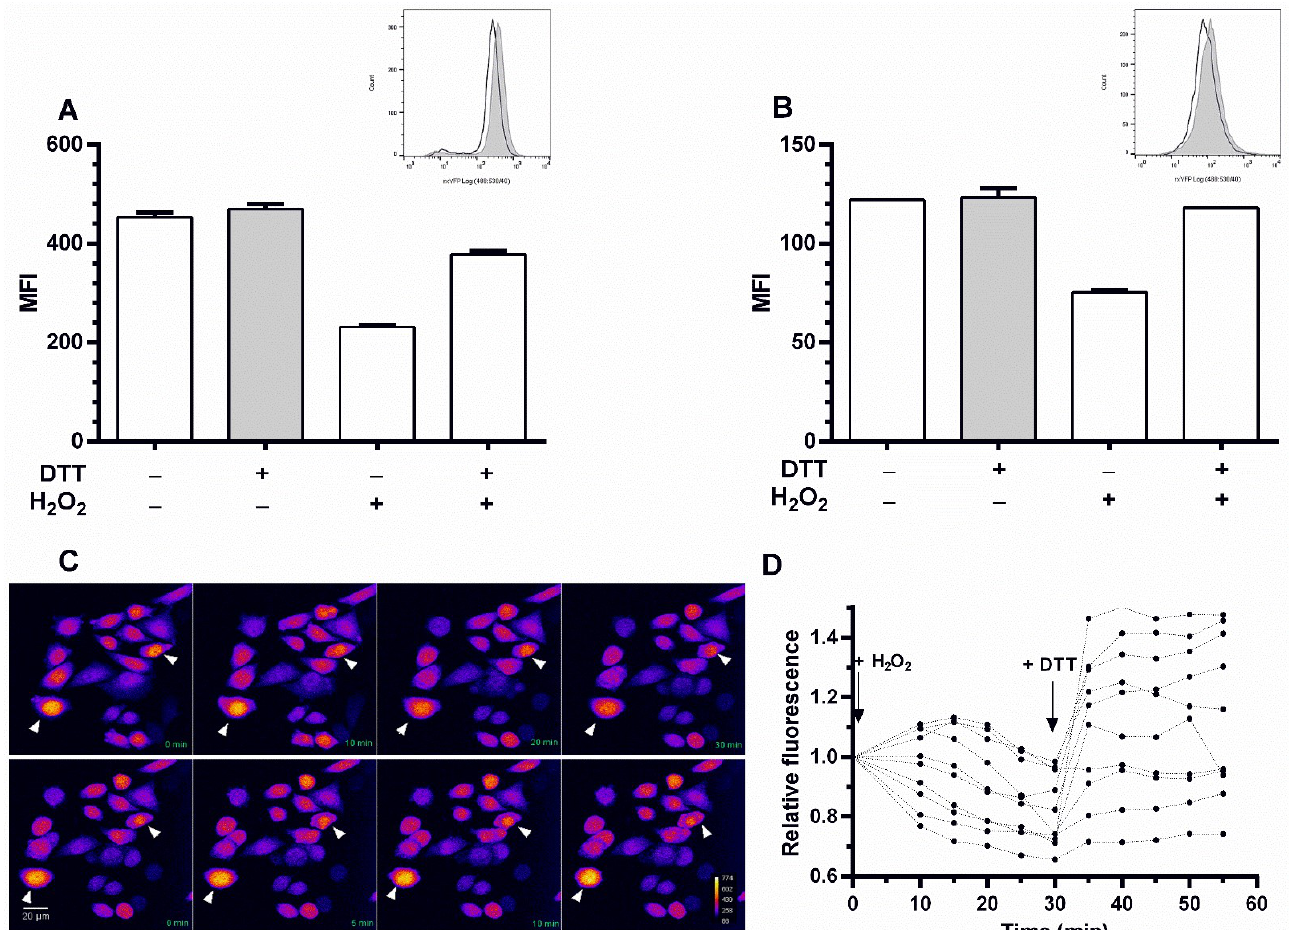
Figure 1. Response of redox reporter cell lines to redox stimuli. rxYFP MFI was measured in ( A ) CHO-GM-rxYFP and ( B ) HEK-293-rxYFP cells treated or not with 2.5 mM H 2 O 2 (30 min) and/or with DTT (for CHO-GM-rxYFP: 1 mM for 20 min, and for HEK-293-rxYFP: 10 mM for 30 min). Data represent the mean of three measurements ± SD. The insets show representative rx-YFP fluorescence intensity histograms for non-treated (filled histogram) and H 2 O 2 -treated (2.5 mM for 30 min, empty histogram) cells. ( C ) Time-lapse measurement of rxYFP fluorescence by confocal microscopy. CHO-GM-rxYFP cells from non-synchronized cultures were treated with 2.5 mM H 2 O 2 for 30 min (upper panel, images taken every 10 min starting from time 0) and then with 1 mM DTT for an additional 25 min (lower panel, images taken every 5 min starting from time 0). The images correspond to the sum of intensity projection for 20 Z-stacks and the fluorescence intensity is represented using a pseudo-color scale. The white arrows point to cells where the changes in fluorescence intensity are more pronounced. ( D ) Quantification of time-course redox-dependent changes in rxYFP fluorescence for 10 selected cells from panel ( C ). The relative fluorescence intensity of each cell is calculated as the MFI normalized to the cell area and the MFI at time 0.